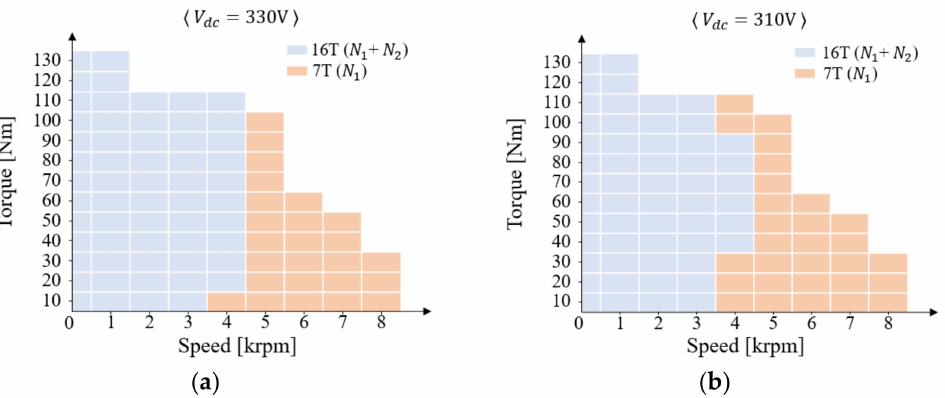
Figure 11. Speed mode selection of the tap-change motor on the speed and torque plane with ( a ) V dc = 330 V and ( b ) V dc = 310